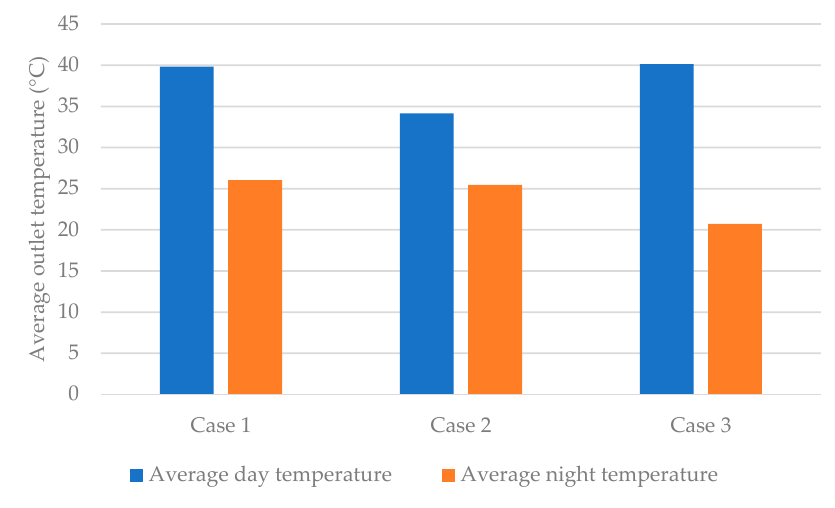
Figure 12. Estimated useful heat rate. Figure 13. Estimated average outlet Figure 13. Estimated average outlet temperatures.